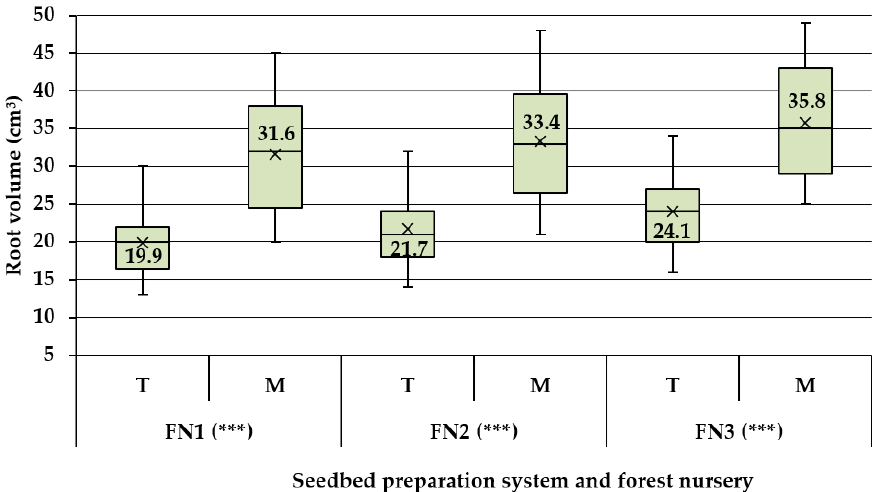
Figure 3. Descriptive statistics and results of the statistical comparison of root’s volume at the forest